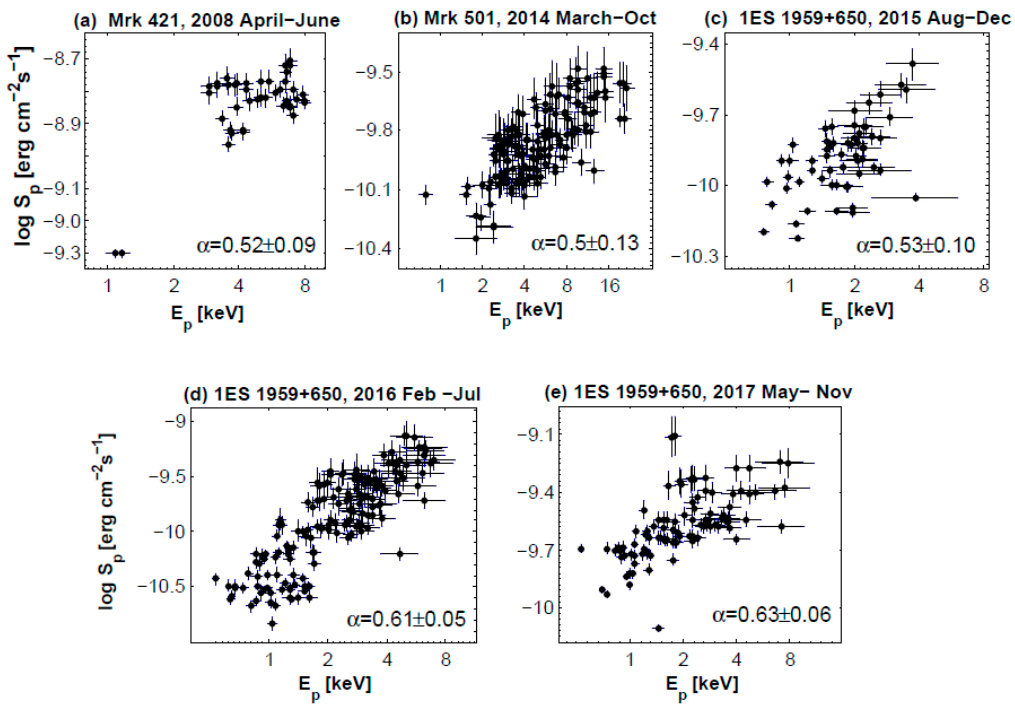
Figure 8. The S p ∞ E α p relationship for the bright HBLs in different periods with α ∼ 0.6 (reproduced Figure 8. The 𝑆 (cid:3043)  𝐸 (cid:3043)(cid:3080) relationship for the bright HBLs in different periods with 𝛼~0.6 (reproduced from References [24,28,31,32]). from References [24,28,31,32]).